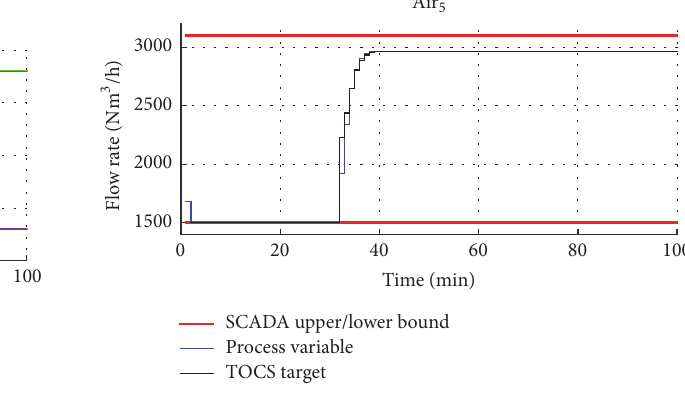
Figure 8: Zone 5 air flow rate